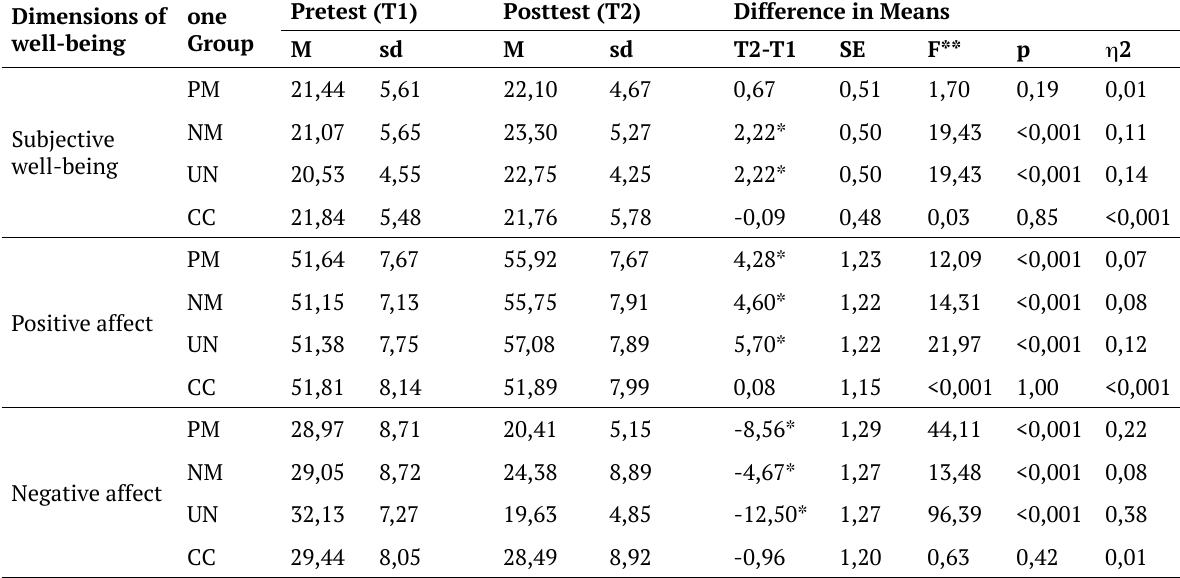
Table 1. Results of one-way within-subjects ANOVA for the particular well-being dimension (pretest and